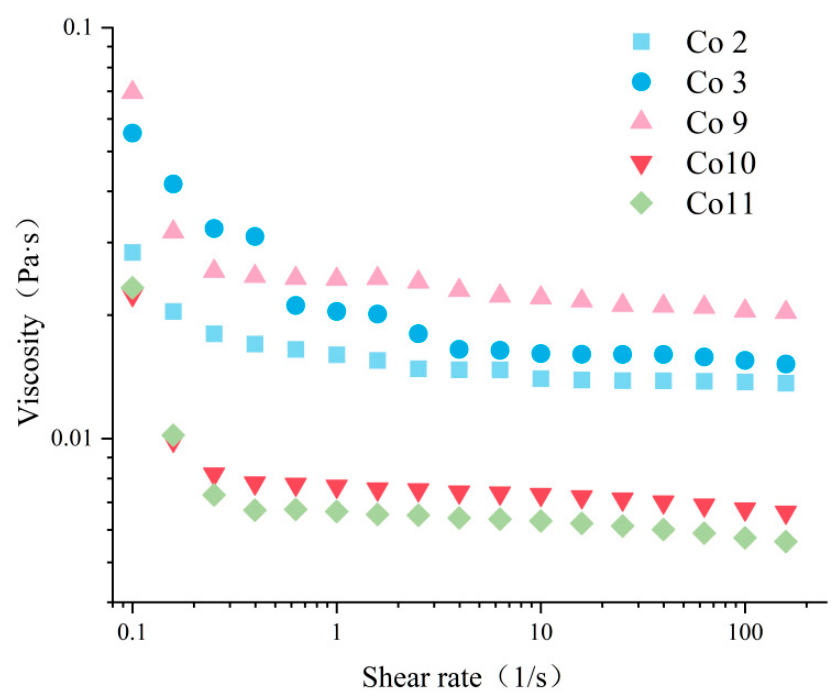
Figure 6. Apparent viscosity of emulsion of Co prepared under different extraction pH conditions.